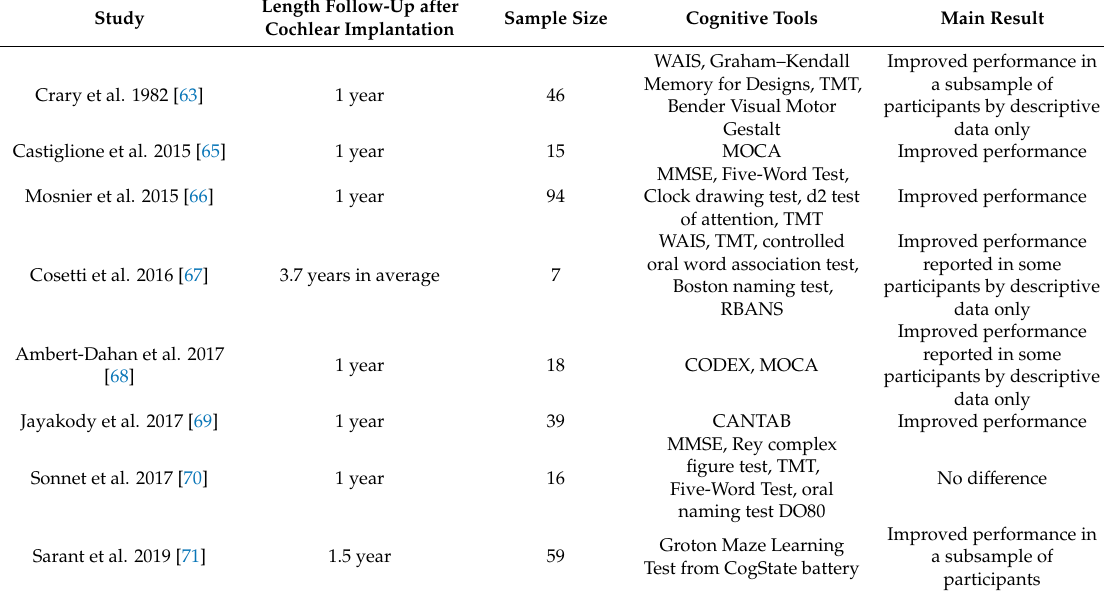
Table 2. Main studies assessing the association between cochlear implantation in older adults and cognitive